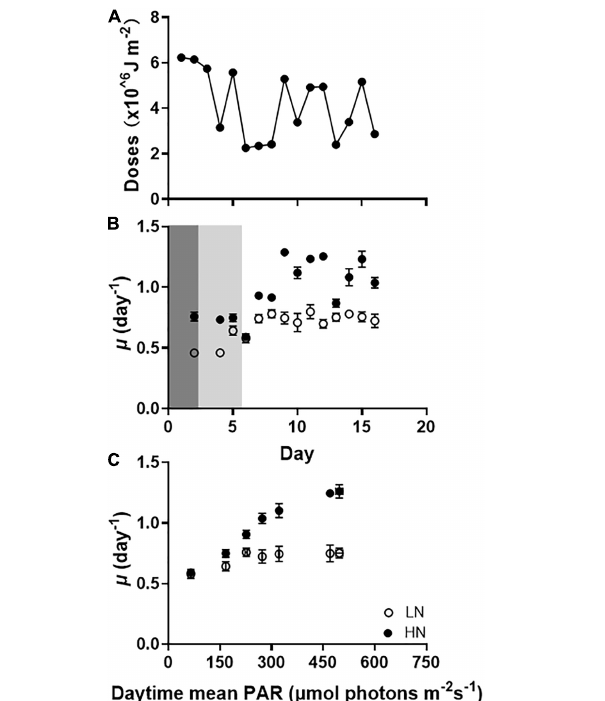
FIGURE 2 | (A) Daily doses of photosynthetically active radiation (PAR) during the outdoor culture periods (from 18th December 2018 to 2nd January 2019). (B) The specific growth rates of Gephyrocapsa oceanica cells grown under fluctuating light regimes and replete (HN) and limited (LN) conditions. Values are the means ± SD of triplicate cultures. The dark gray and light gray darkened areas indicate the periods of reduced levels of solar radiation for the cells to acclimate from 17 to 30% and then to 100% incident sunlight. (C) The specific growth rates of the cells grown at HN and LN as a function of daytime mean light levels. The values of daytime mean PAR exposed to the algal cells was 89% incident